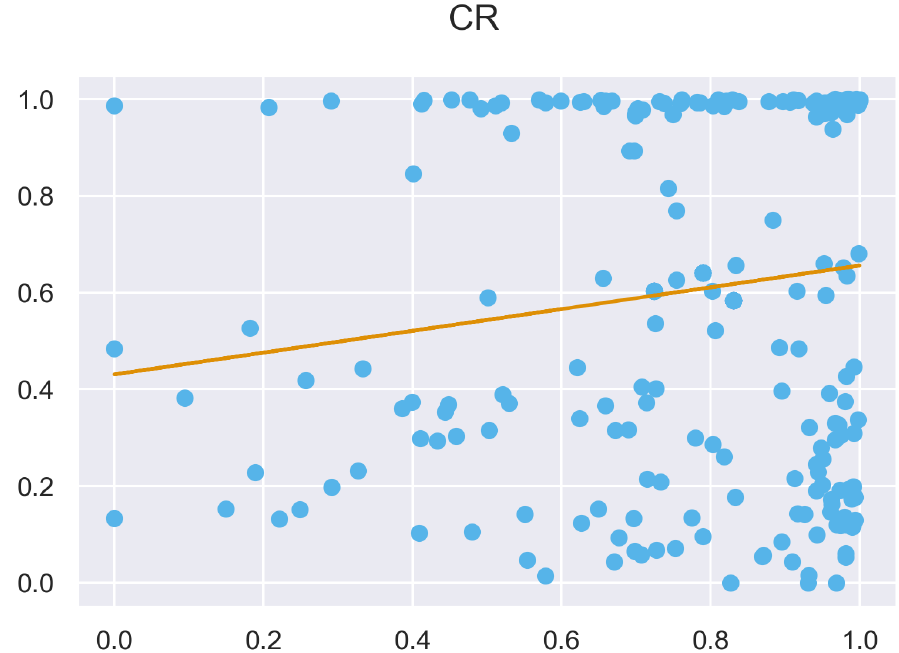
Figure A47. ULS and TLS CR regression at 5m grid size.